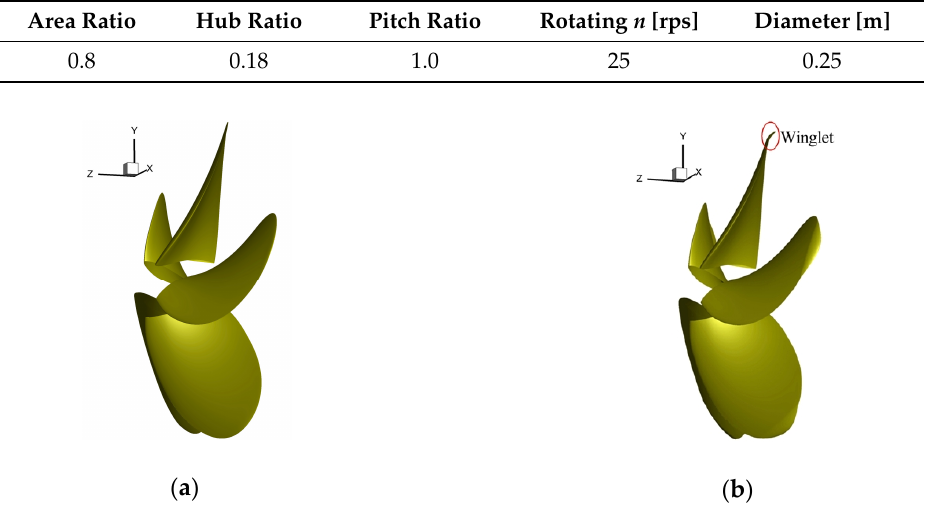
Table 1. Propeller geometry.